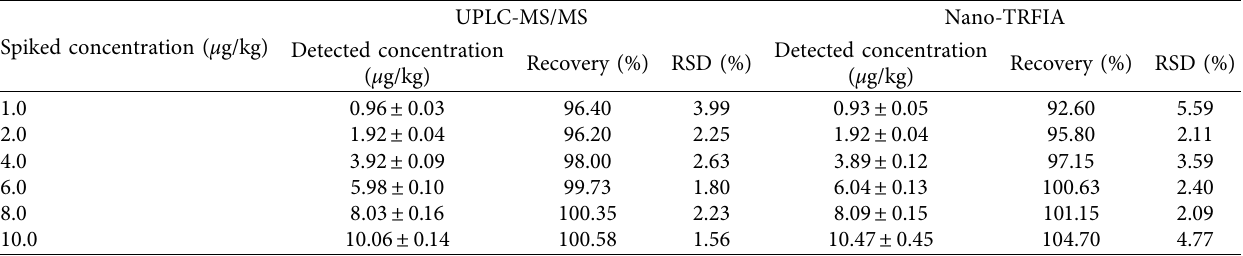
Table 3: Comparison of nano-TRFIA and UPLC-MS/MS for CPZ detection in pork ( n � 5).